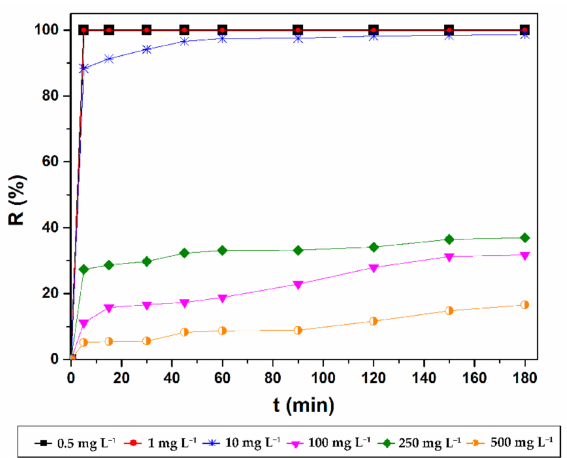
Figure 6. Effect of contact time on CV removal efficiency of